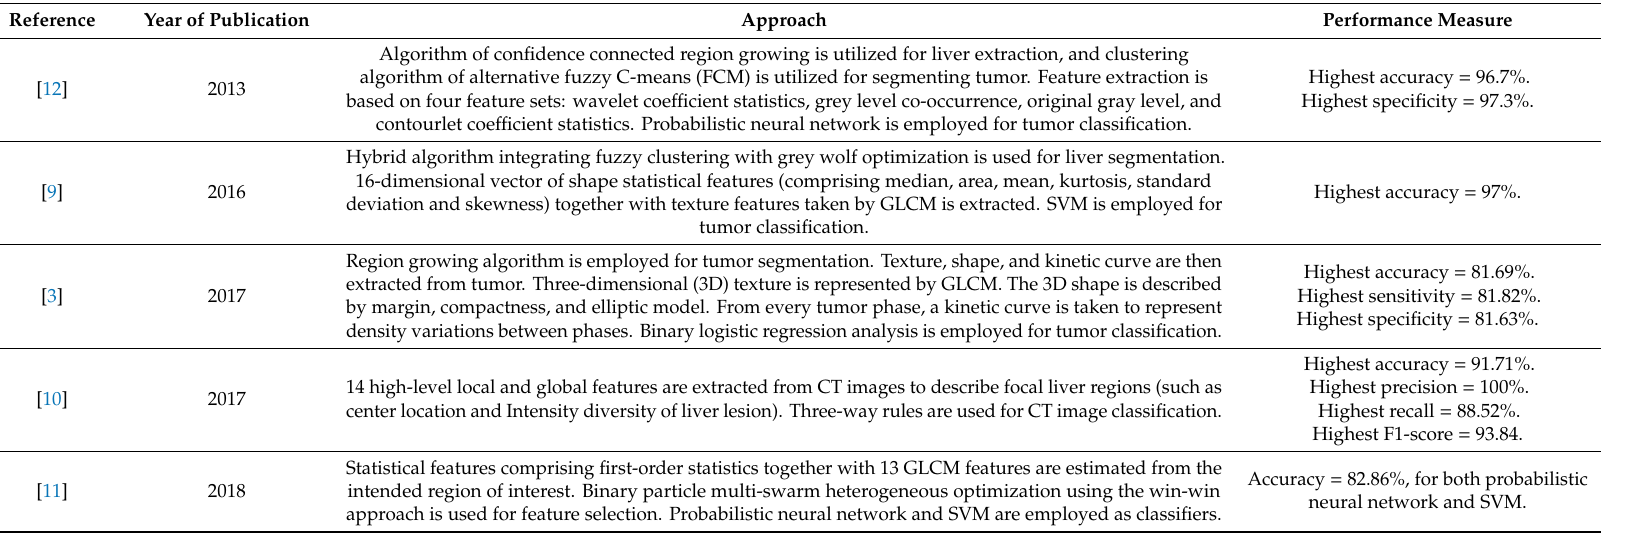
Table 1. Review on feature engineering methods utilized in liver cancer diagnosis from computed tomography (CT) images.